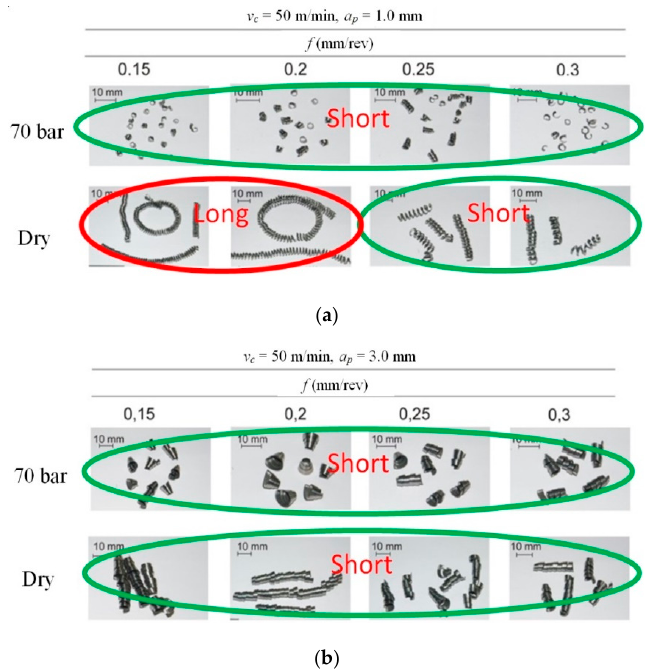
Figure 8. Chip geometry classification for HPC machining and dry machining as a function of the feed for ( a ) cutting depth a p = 1.0 mm; ( b ) cutting depth a p = 3.0 mm.